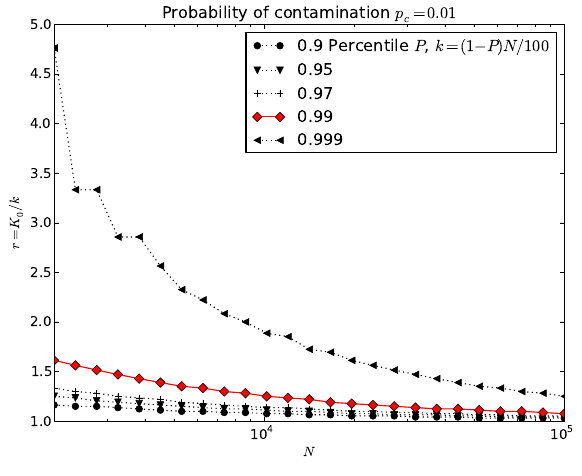
Figure 9. The upper and lower 95% CIs and the mean 100-year re- turn estimates (dashed) based on M = 1000 bootstrap resamples for various choices of resample threshold K 0 for the sample in Fig. 2. Upper panel: a GPD with shape parameter ξ = 0 (exponential distri- bution). Lower panel: a GPD with freely varying shape parameter. Individual bootstrap estimates are marked in grey. Estimates based on the full sample D 0 are marked as asterisks on the